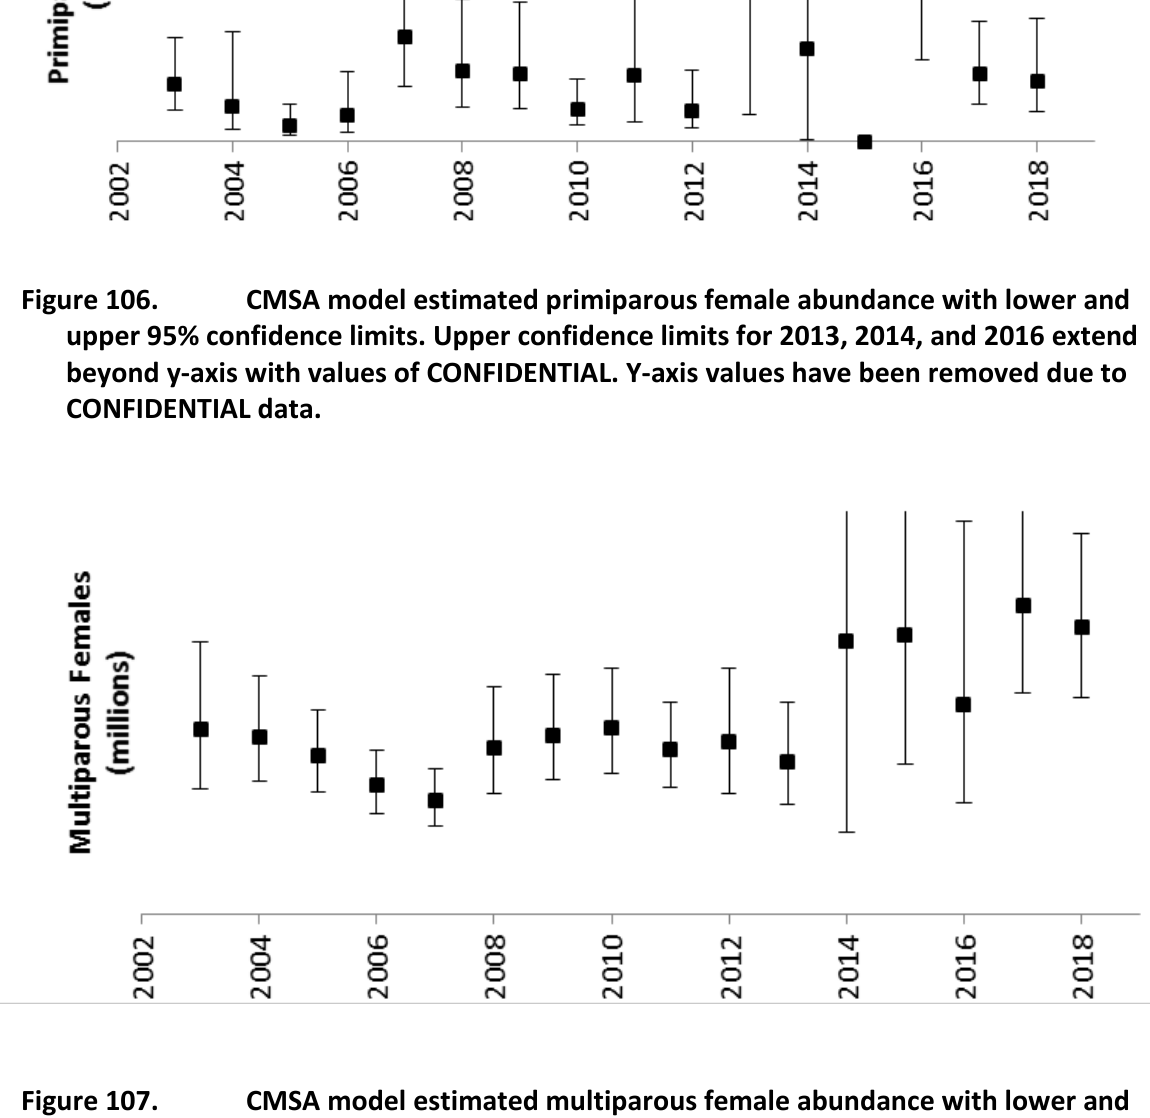
Figure 107. CMSA model estimated multiparous female abundance with lower and upper 95% confidence limits. Upper confidence limits for 2014, 2015, and 2017 extend beyond y-axis with values of CONFIDENTIAL. Y-axis values have been removed due to CONFIDENTIAL